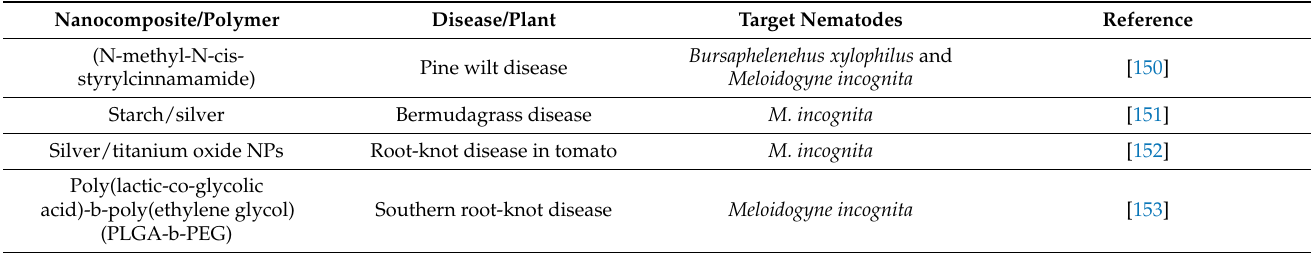
Table 5. Polymeric nanoparticles developed as carriers of nanonematicides.